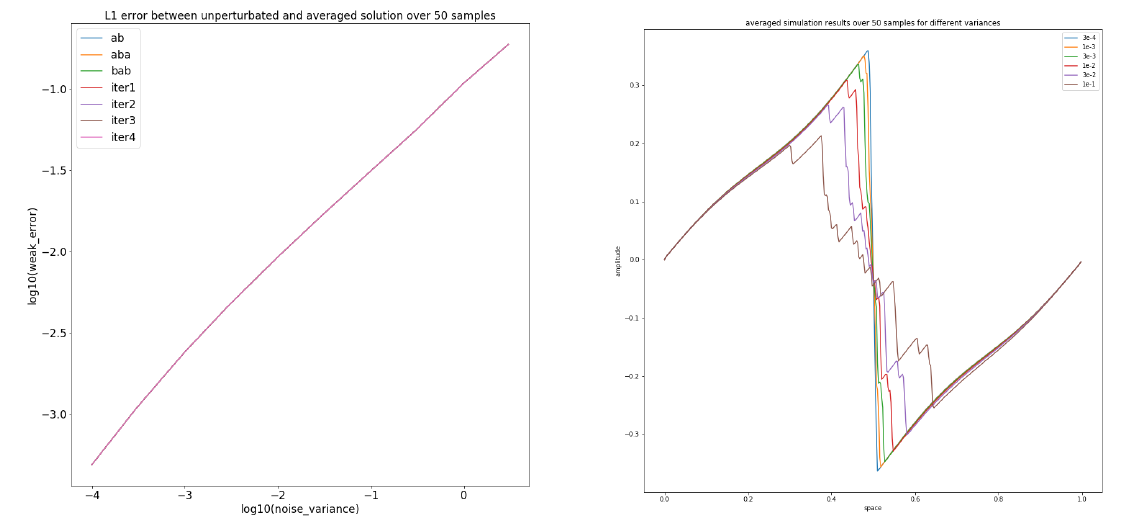
Figure 6. In the left-hand panel, we see L 1 error between unperturbed solution and average over 50 perturbed solutions, while we have applied the L 1 -error given in Equation (73). We obtain a relation between small variances and small numerical errors. Therefore the control of higher variances are important. The right-hand panel presents the averaged results for difference variances in the iterative splitting approach method, which are given for the W ( t ) stochastic process with E 2 ( ∆ W ) = 1 × 10 − 1 , . . . ,3 × 10 − 4 . For high variances around 0.1, we obtain a strong influence to the numerical